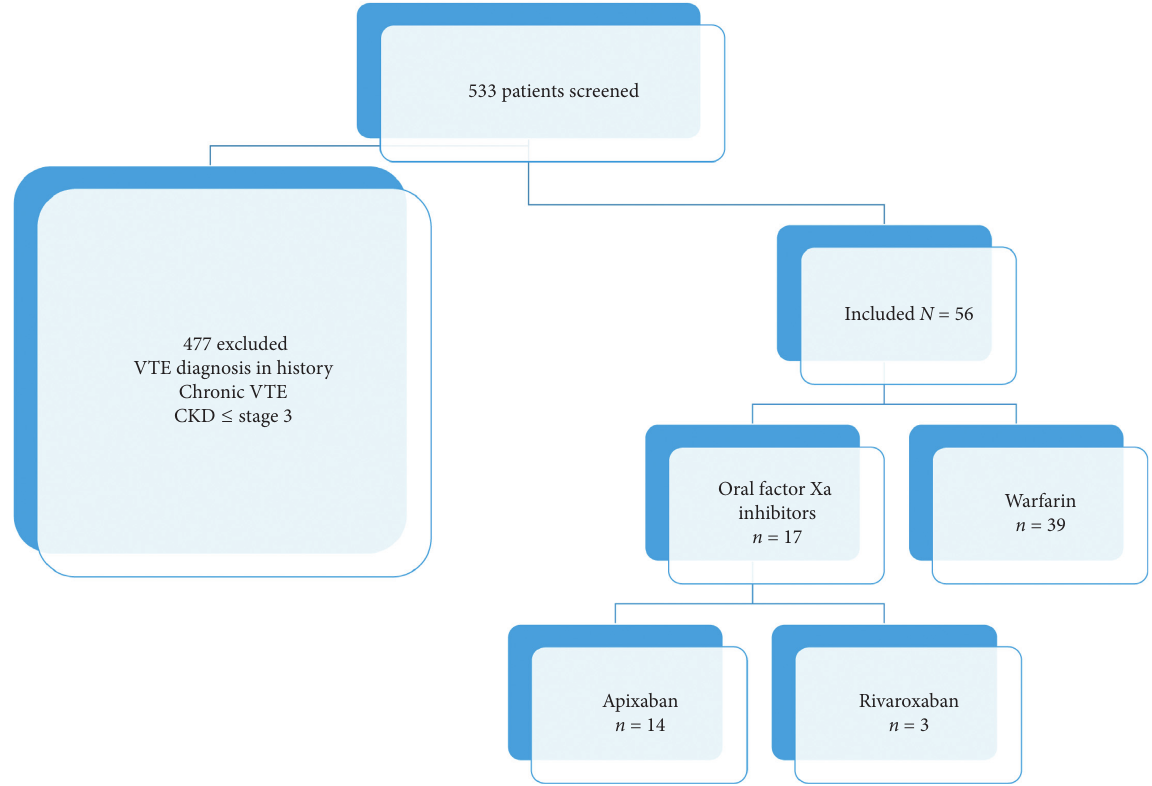
Figure 1: Patient cohort including total number of patients screened and number of patients excluded and